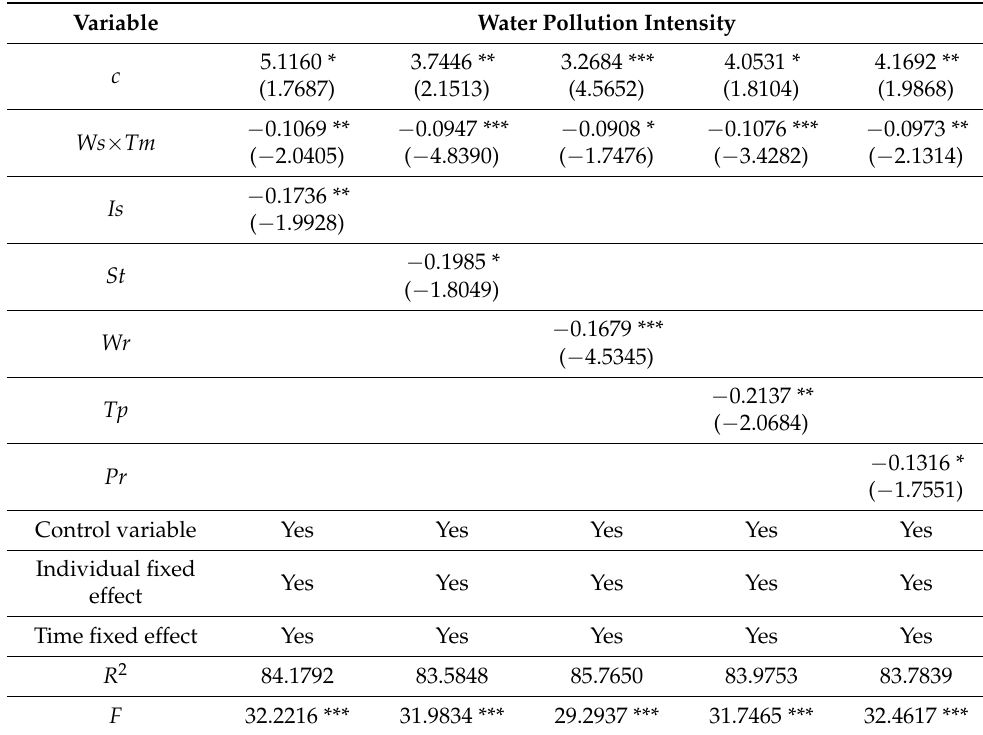
Table 6. Estimation results of the mechanism